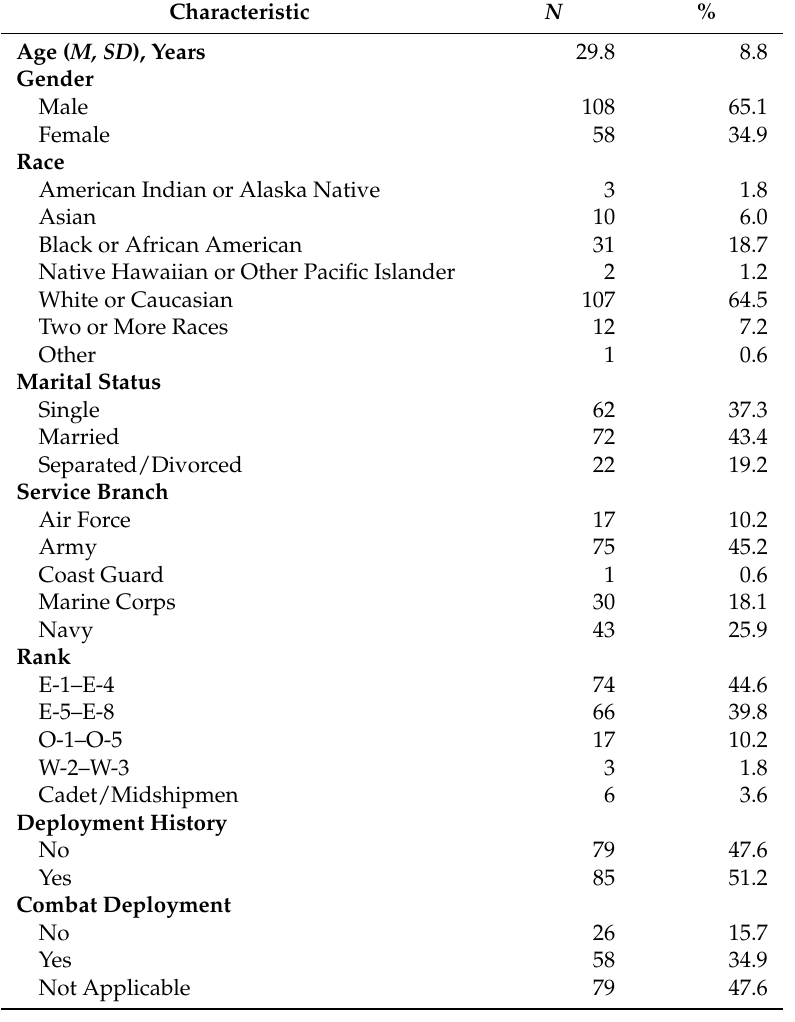
Table 1. Demographic and military service characteristics of military psychiatric inpatients hospitalized following a suicide crisis ( N =